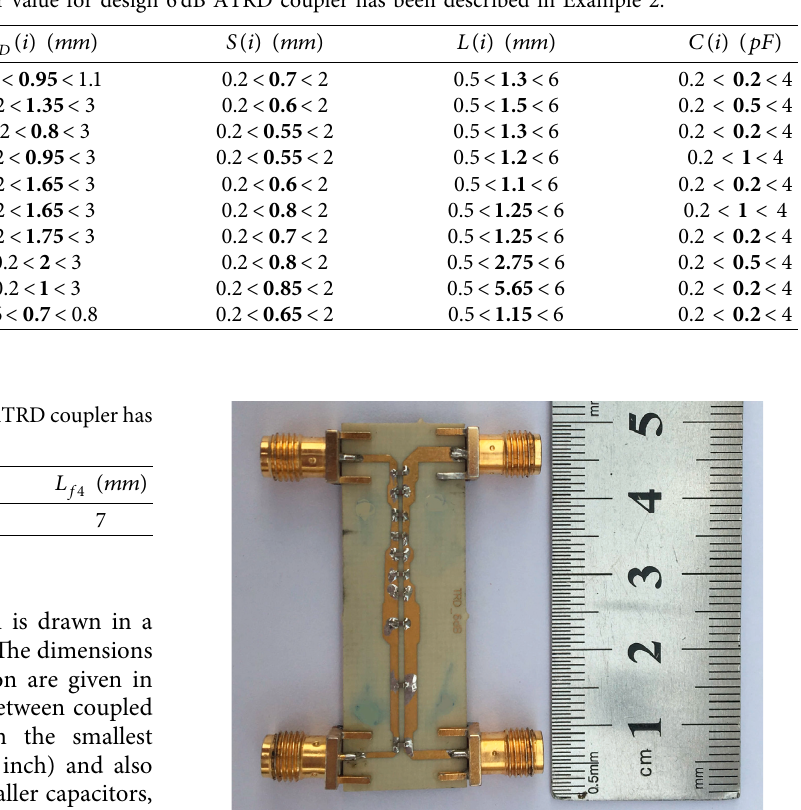
Figure 12: Fabricated 6dB ATRD coupler of Example